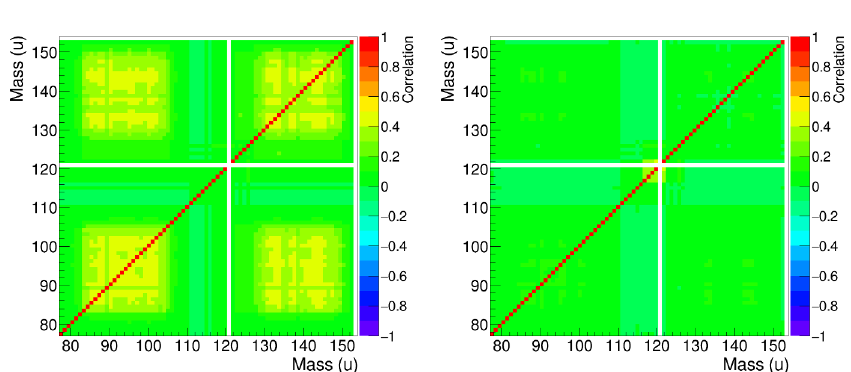
Figure 2. Preliminary results. (left) Mass yields correlations for 8 datasets after normalization to the 3 th set; (right) the same in reference to the 4 th set.